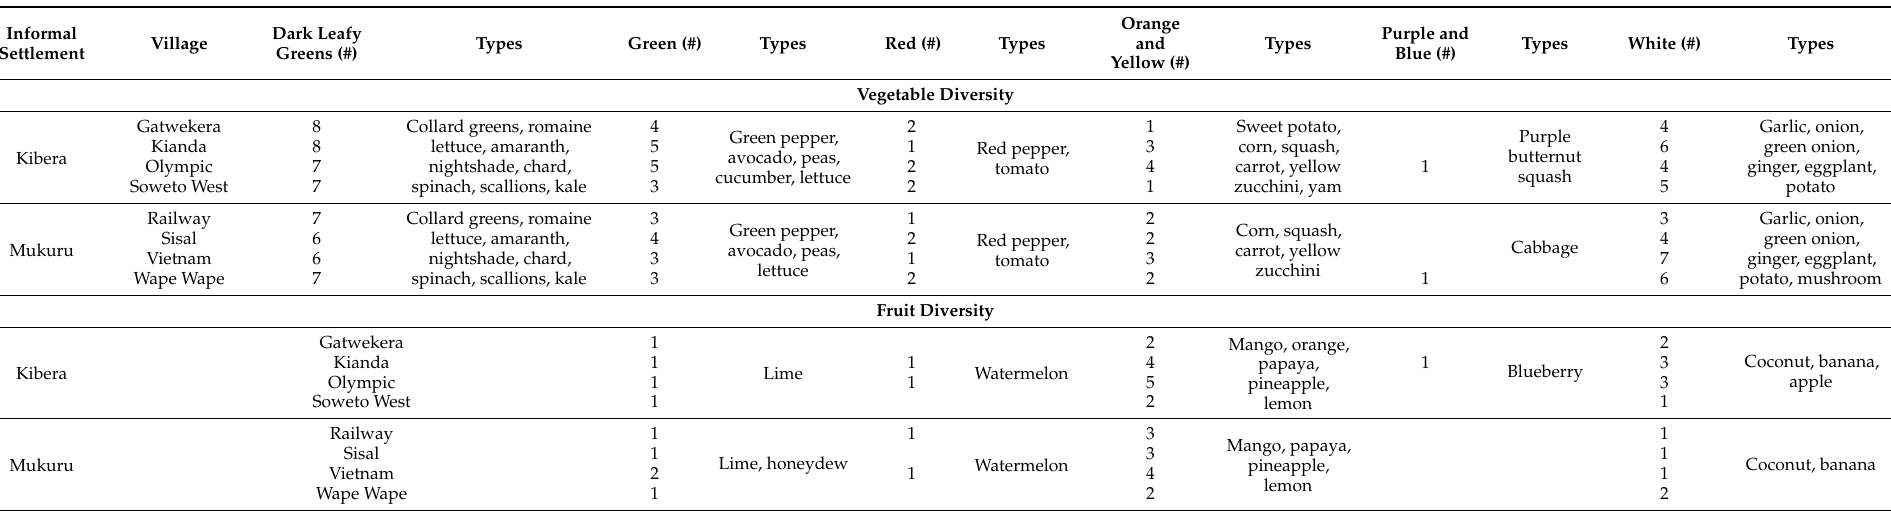
Table 1. A summary of the ProColor diversity scores of vegetables and fruits in villages within Kibera and